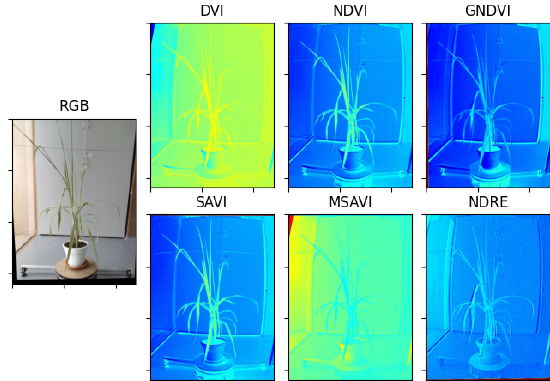
Figure 12. Result of the estimation of vegetative indexes in the Limonaria plant. Algorithm 6: Estimation of the coordinates of the axis of rotation of the rotating